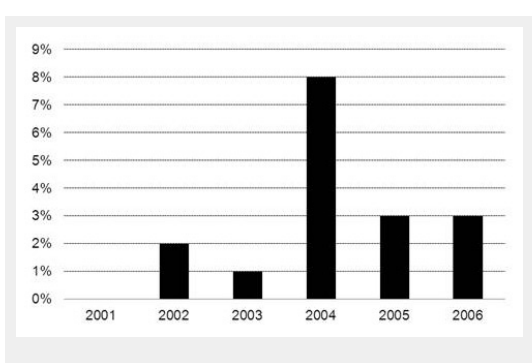
Percentage of negative appendectomies by the surgeon during the